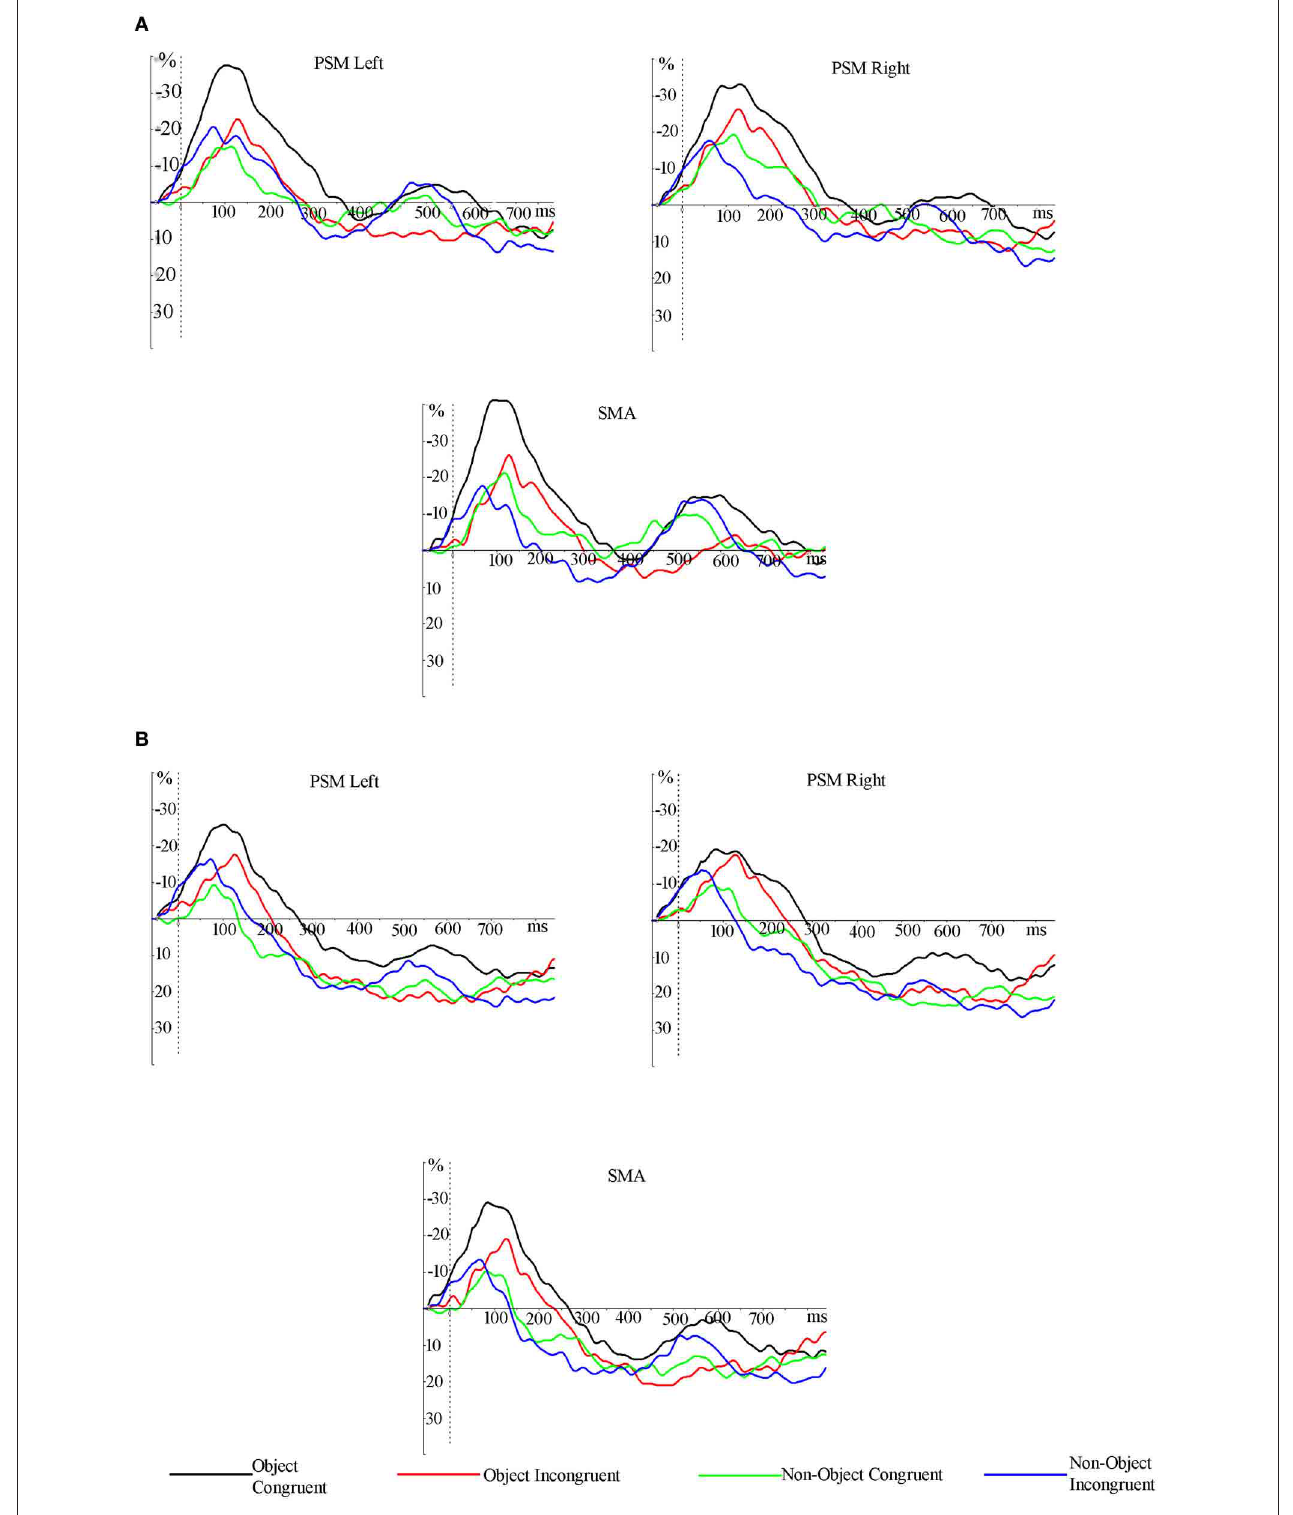
FIGURE 5 | Grand averaged ERD/ERS traces (smoothed across a 100ms moving window) from electrodes pooled across the scalp regions of primary sensory motor area and supplementary motor area (PSM and SMA). ERS for non-objects started earlier than for objects and ERD related to